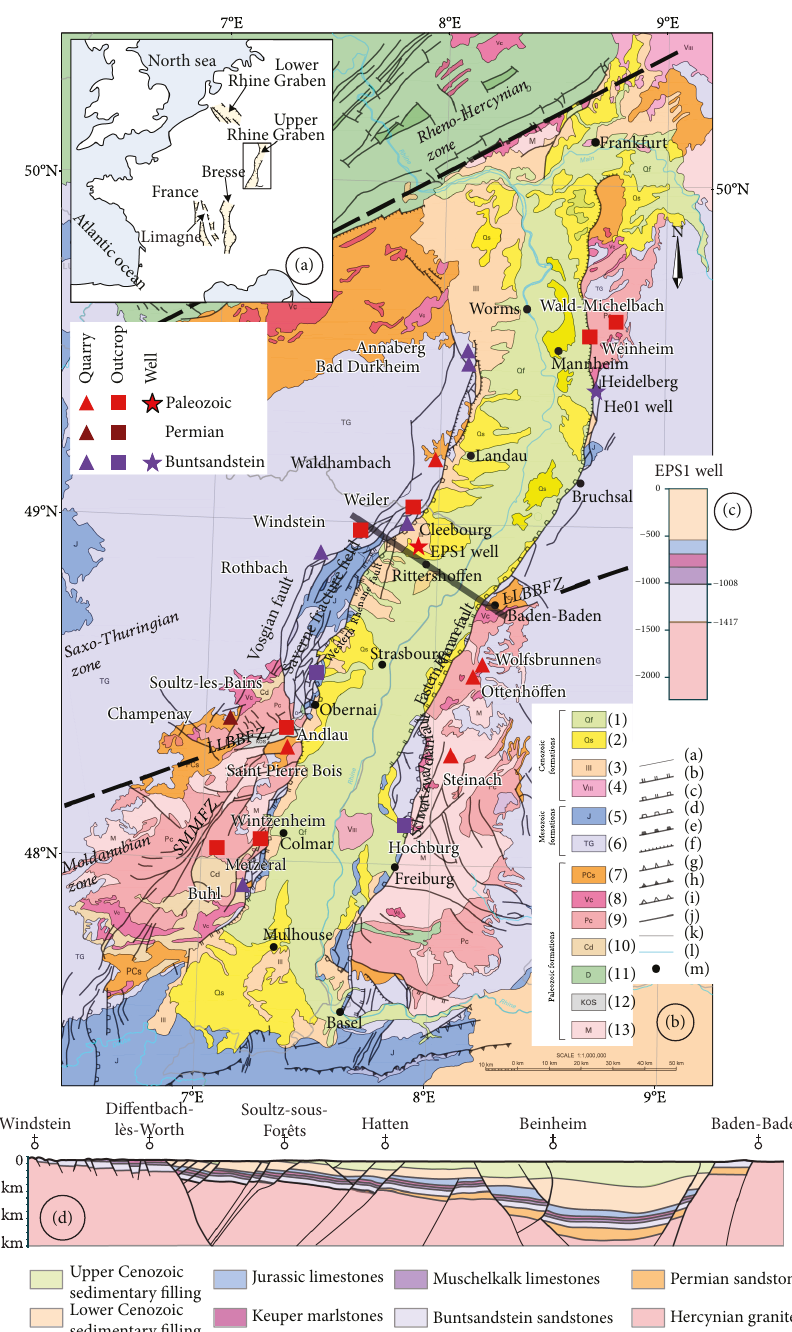
Figure 1: Geological setting. (a) Location of the Rhine graben in Western Europe. (b) Geological map from [114] showing location of sampling sites, quarries, outcrops, and wells. (1) Quaternary fl uvial deposits; (2) Quaternary loess, eolian deposits; (3) Tertiary marine and lacustrine limestones, marls, evaporites; (4) Tertiary basalt; (5) Jurassic limestones; (6) Triassic sandstones, marly limestones, and anhydrite (German Triassic); (7) Permian red sandstones; (8) Carboniferous volcanism; (9) Carboniferous granites; (10) Dinantian conglomerate; (11) Ordovician-Silurian limestones and continental altered rocks; (12) Ordo-Silurian-Cambrian clay and argillaceous sandstones; (13) Siluro-Devonian paragneiss and orthogneiss. (A) Geological contact; (B) syn- to post-Quaternary fault; (C) syn- to post-Plio-Quaternary fault; (D) syn- to post-Pliocene normal fault; (E) syn- to post-Miocene normal fault; (F) undated fault; (G) syn- to post-Quaternary thrust; (H) syn- to post-Pliocene thrust; (I) undated thrust; (J) undi ff erentiated fault; (K) boundary; (L) main river; (M) city. (c) Geological log of the Soultz EPS1 well [59, 115]. (d) Geological W-E cross section through Soultz-sous-Forêts based on a 3D geological modem from [116]. Common legend for (c) and